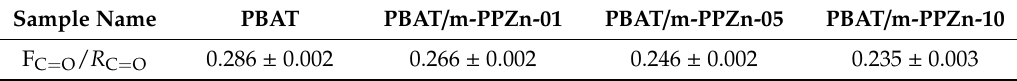
Figure 7. FTIR deconvolution spectrum of PBAT after 21 days UV irradiation. Table 1. Ratio of F C = O to R C = O of samples after 21 days UV